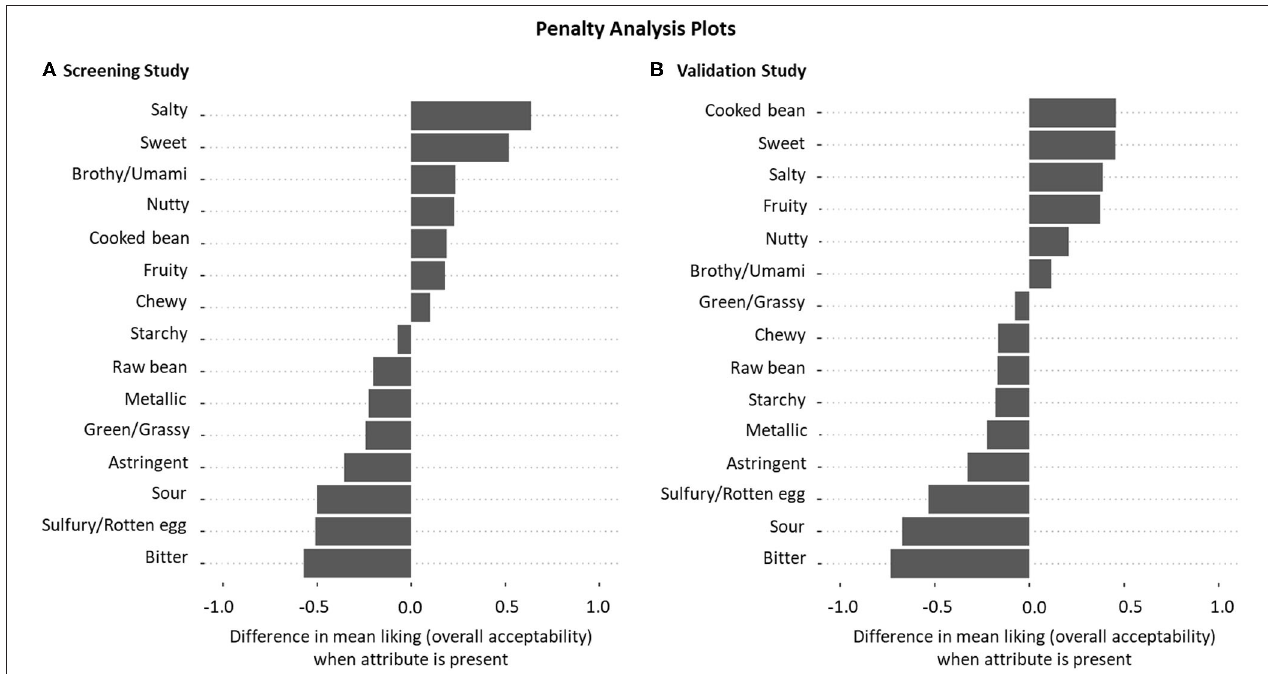
FIGURE 2 | Penalty analysis plots representing the impact of sensory descriptors from the Check-All-That-Apply (CATA) list in the overall acceptability scores of edamame genotypes. (A) corresponds to the screening study and (B) corresponds to the validation study.